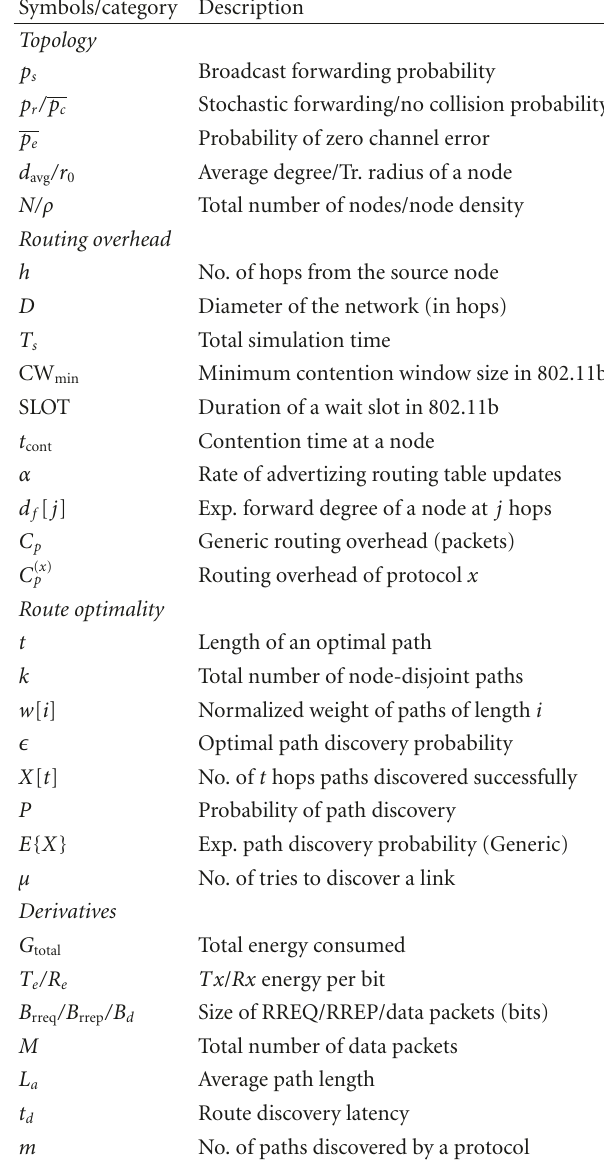
Table 1: Description of modeling